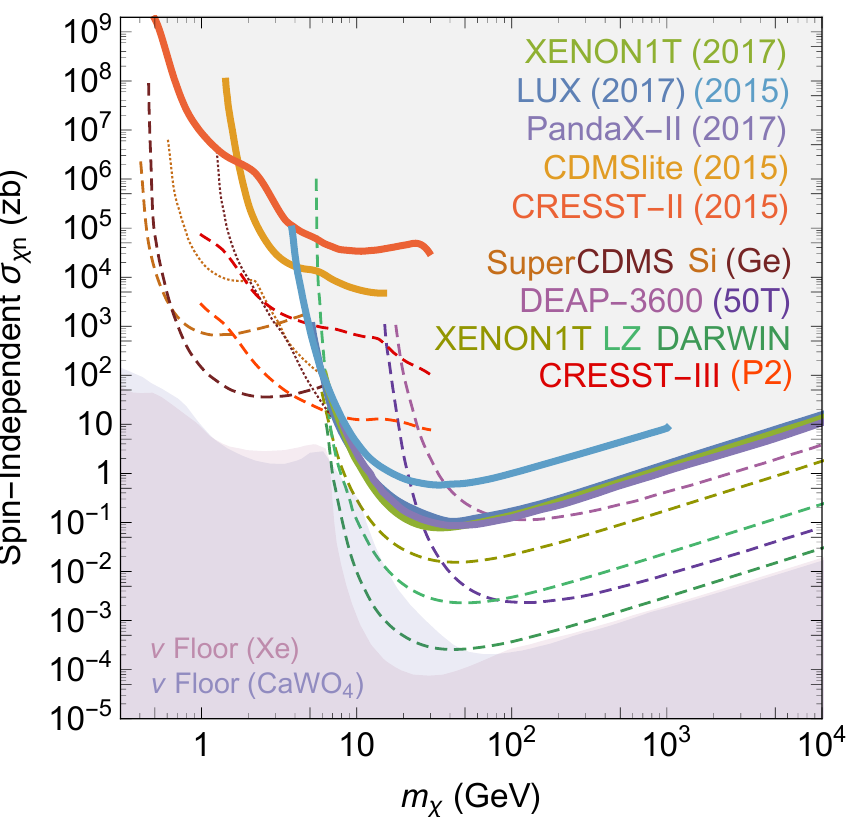
Figure 3 . The shaded gray region represents the current exclusion from the combined results of XENON1T [23], LUX [24, 25], PandaX-II [26] CDMSlite [27], and CRESST-II [28]. Also shown in dashed lines are the projected limits from argon-based DEAP-3600 as well as its proposed 50 ton-year upgrade [31]; the xenon-based experiments XENON1T [32], LUX-ZEPLIN (LZ) [33], and DARWIN [34]; the CaWO 4 -based CRESST-III and its Phase 2 upgrades [35] and the projected limits from SuperCDMS [36] for both silicon and germanium for both the interleaved Z-sensitive Ionization and Phonon (iZIP) detectors (thin, dotted) and those run in high voltage (HV) mode (dashed). The coherent neutrino scattering (cid:13)oor is shown for both CaWO 4 and xenon [37, 38]. The (cid:13)oor for silicon, germanium, and argon is very similar to xenon, while more complex materials, like the CaWO 4 in CRESST and the proposed EURECA [39] experiment, can have a substantially di(cid:11)erent (cid:23)